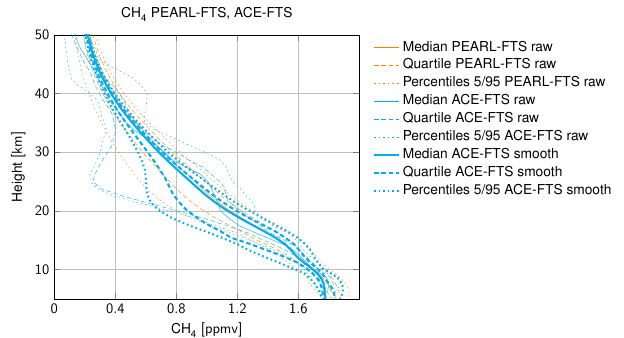
Figure 9. Distribution of retrieved methane profiles for all collo- cations between PEARL-FTS and ACE-FTS. In this and following figures, the solid line indicates the median value for the set of all col- located profiles as a function of altitude. The dashed line indicates the 1st and 3rd quartile (25th and 75th percentile), and the dotted line indicates the 1st and 99th percentile. The set of thin lines shows the distribution of the unsmoothed profiles, labelled “raw” and in- terpolated on a shared altitude grid, whereas the thick lines show the smoothed profiles. The calculation method is described in the text.